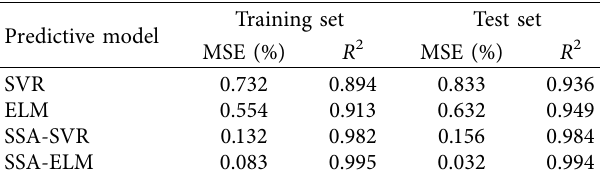
Table 1: Comparative analysis of the water-content prediction